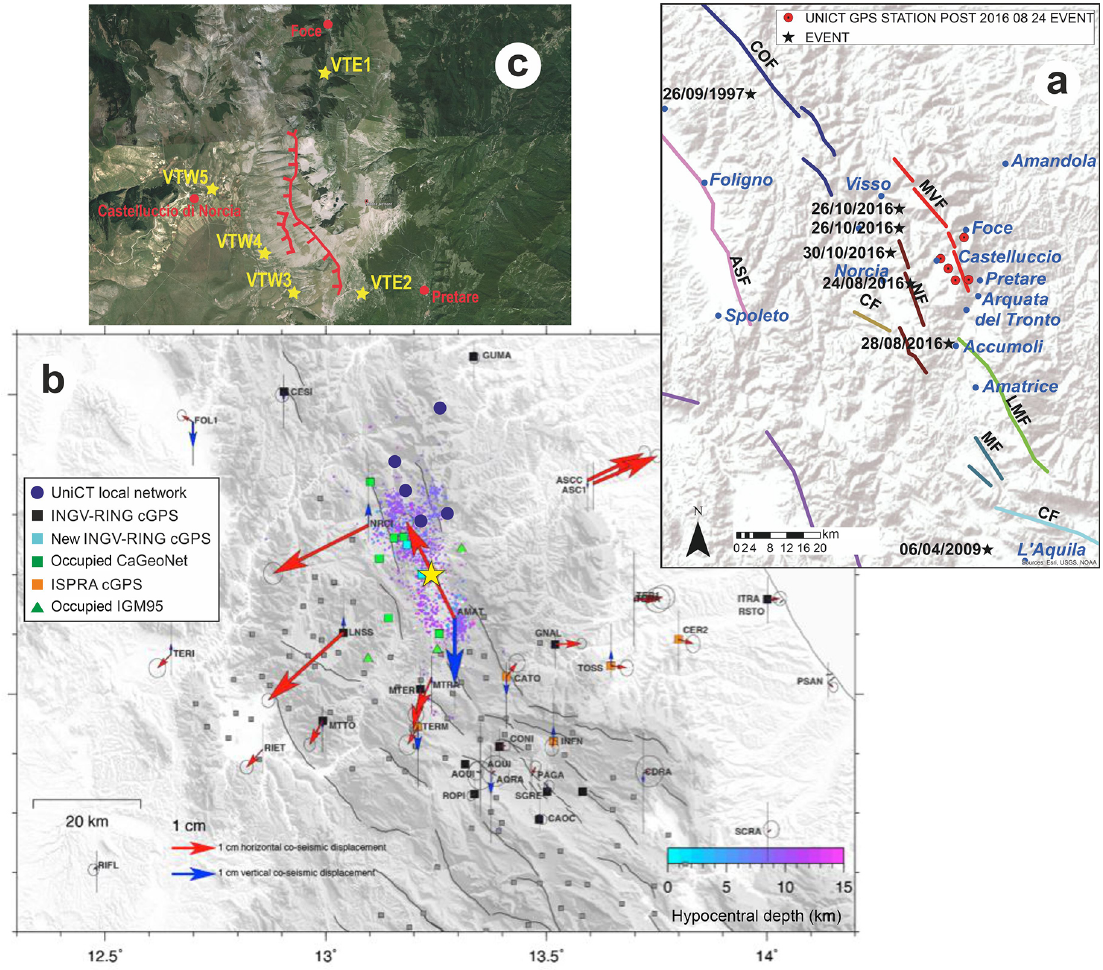
Figure 2. (a) Digital elevation model with shaded relief of the central Apennines showing the active fault system and the major events since 1997 (ASF: Assisi fault; COF: Colfiorito fault; CF: Cascia fault; MVF: Mt Vettore fault; NF: Norcia fault; LMF: Laga mountain range fault; MF: faults of the Montereale basin). (b) Horizontal (red arrows) and vertical (blue arrows) consensus co-seismic displacements (with 68% confidence errors), and the local UniCT GPS network. The aftershocks of 24 August, M w = 6 . 0 main event (yellow star) are coloured as a function of depth (from http://iside.rm.ingv.it). (c) Google Earth map showing the new five GNSS stations (yellow stars) located in the near field (and surrounding) of the 30 October coseismic ground ruptures (red